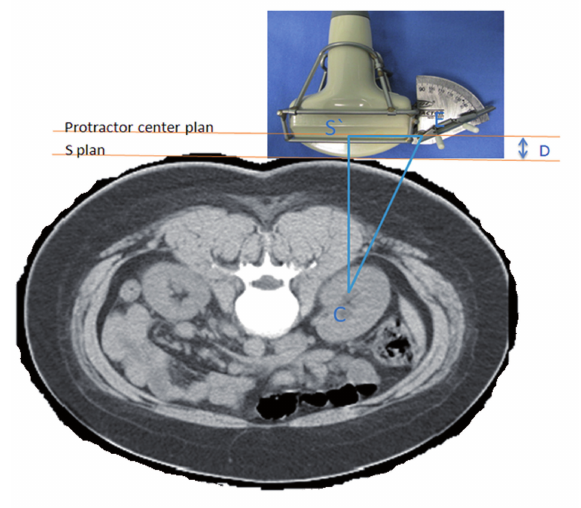
Figure 2 - Formation of the right triangle. S`C: Distance from the target calyx (C) to its orthogonal projection on the plane of the center of the protractor (S`). S`E: Distance between point S` and the center of the protractor (E). CE: Distance from the target calyx (C) to the center of the protractor (E). D: Distance between the